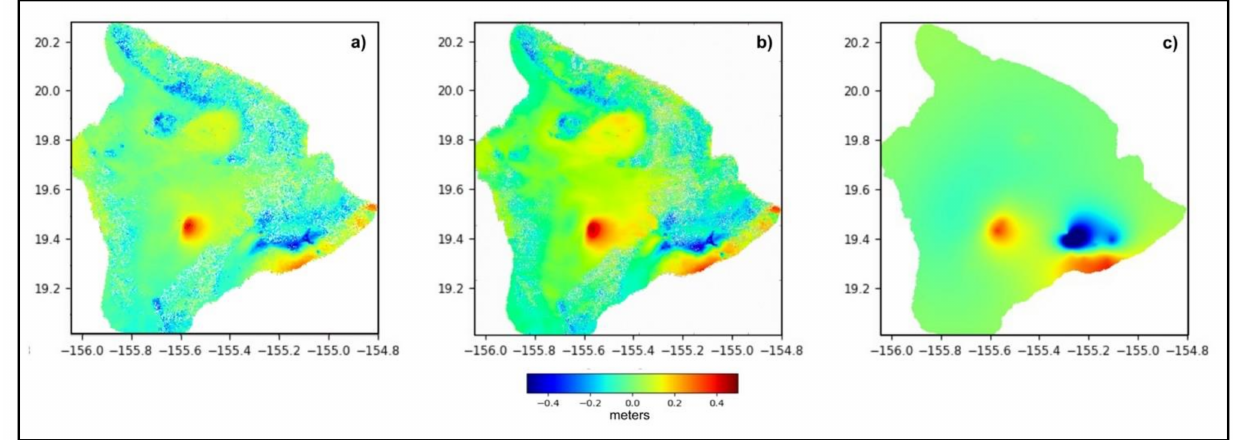
Figure 6. Comparison of ( a ) the final time-step of the integrated time series converted to LOS with ( b ) the final cumulative LOS DInSAR scene and ( c ) the final cumulative GNSS interpolated map, also converted to LOS.